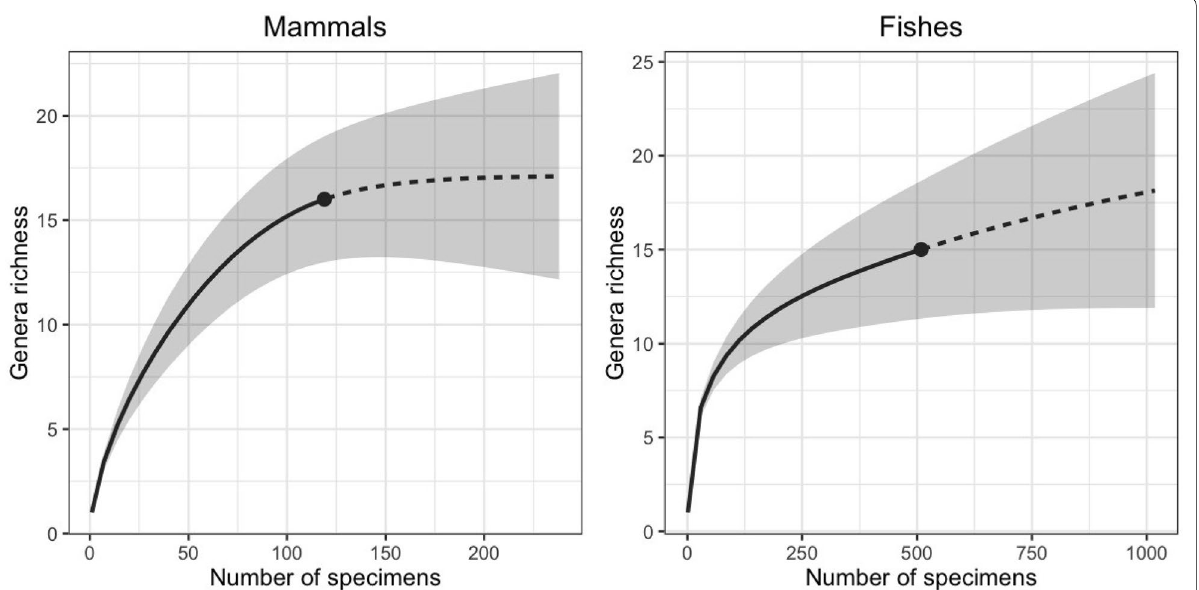
Fig. 32 Sample size‑based sampling curves for mammals and fishes recorded in Norte Casa Chiguaje. The plots show the rarefaction (solid lines), and extrapolation (dotted lines) sampling and the 95% confidence intervals (shaded areas) for the generic richness of mammals and